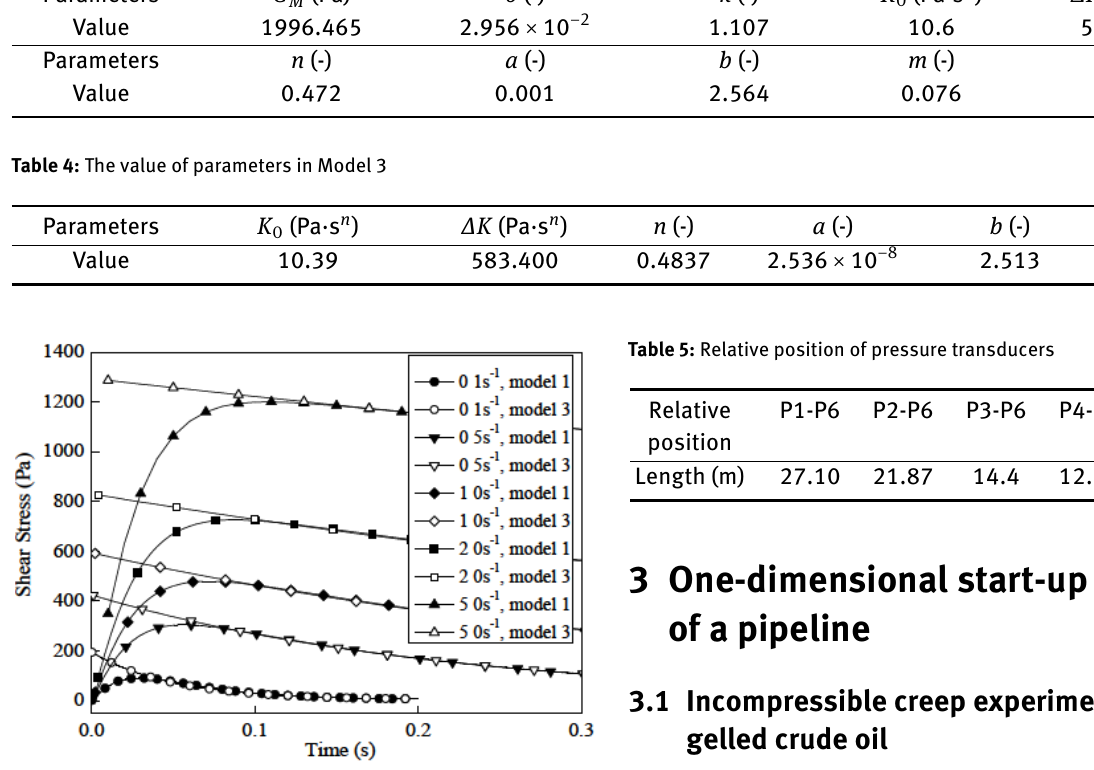
Figure 8: The partial graph of rheological data between Model 1 and Model 3